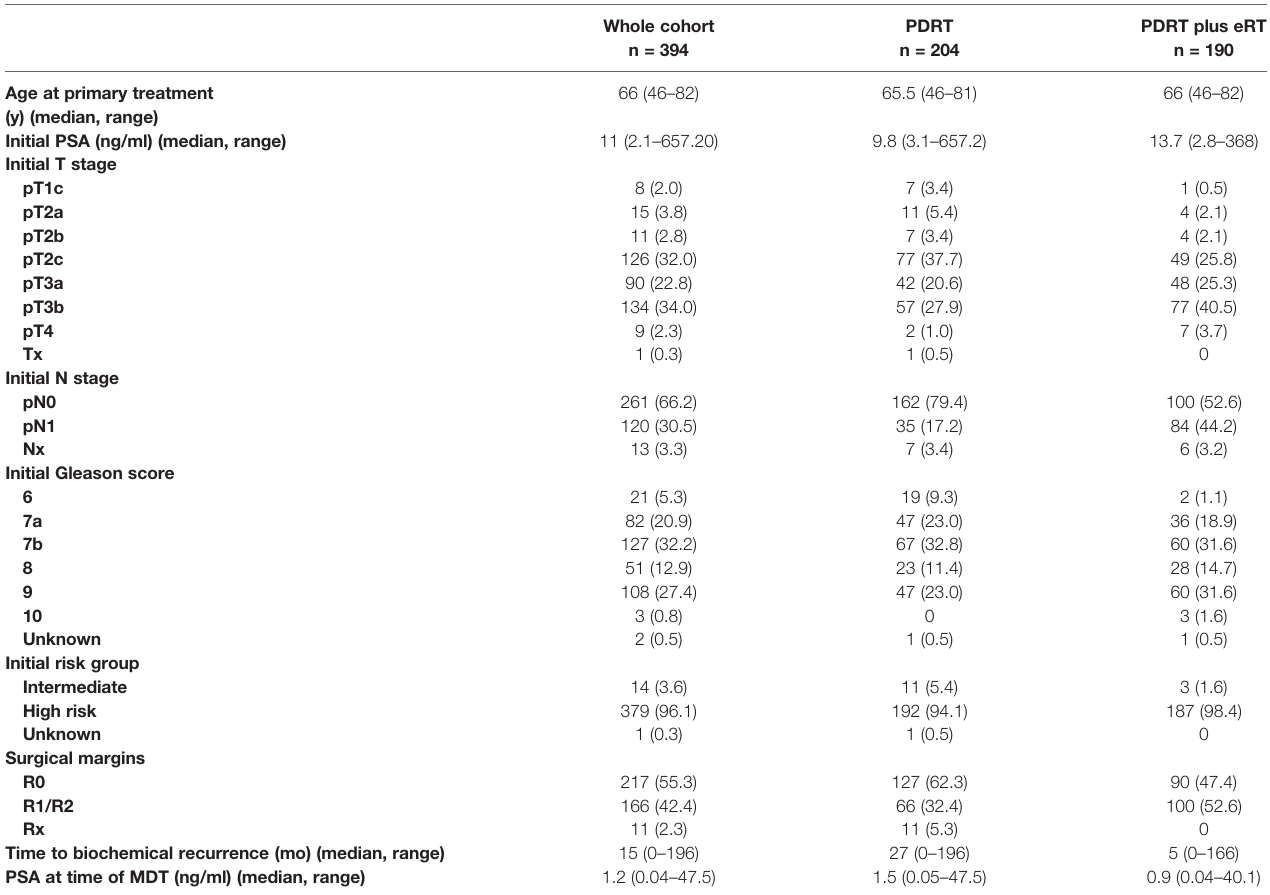
TABLE 1 | Patient